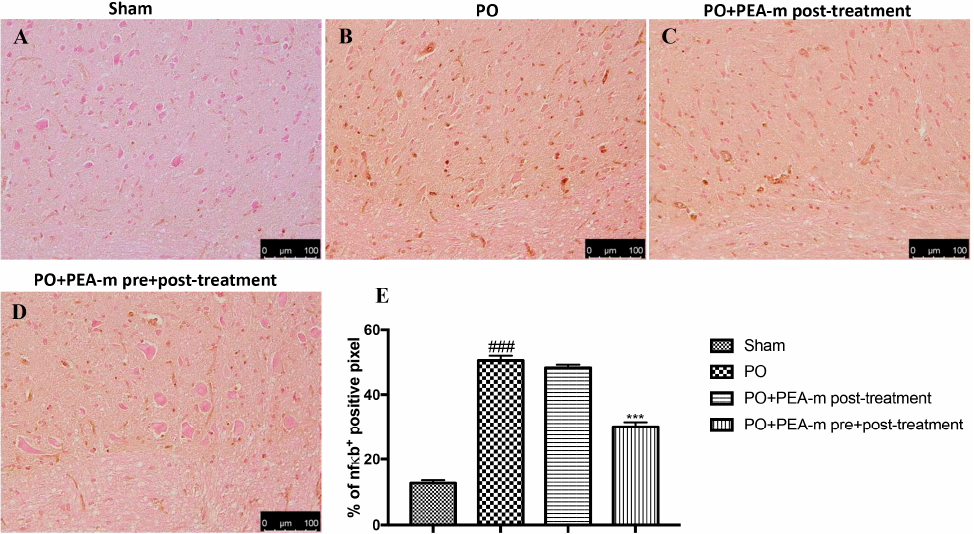
Figure 7. E ff ects of PEA-m on levels of nuclear factor kappa-light-chain-enhancer of activated B cells (NF- κ B). Immunohistochemical analysis showed no staining for NF- κ B in the sham group ( A ). Increased NF- κ B expression was observed in the lumbar spinal cord collected 24 h after PO ( B ). A non-significant reduction was observed in the PO + PEA-m post-treatment group ( C ), while low levels of NF- κ B were found in rats treated with PEA-m both before and after plantar incision (D). The data are also presented graphically as percentage of positive cells ( E ). *** p < 0.001 vs. sham; ### p < 0.001 vs.